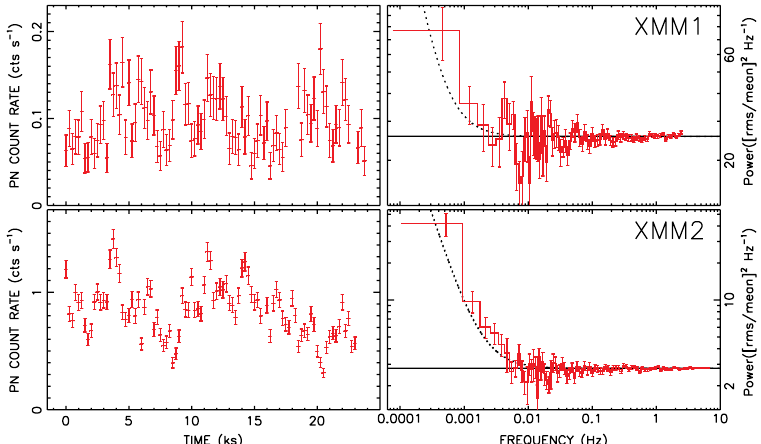
Figure 6. Left panels: The pn 250 s 0.2–2.0 keV background-subtracted light curves. Right panels: The PDS of the pn 0.2–2.0 keV light curves binned at 199.1 ms for XMM1 and 73.4 ms for XMM2. The black solid constant line is the average PDS above 0.1 Hz, representing the Poisson level, and the dotted line is the best-fitting model of a PL plus a constant [19]. are consistent with being the same within the error